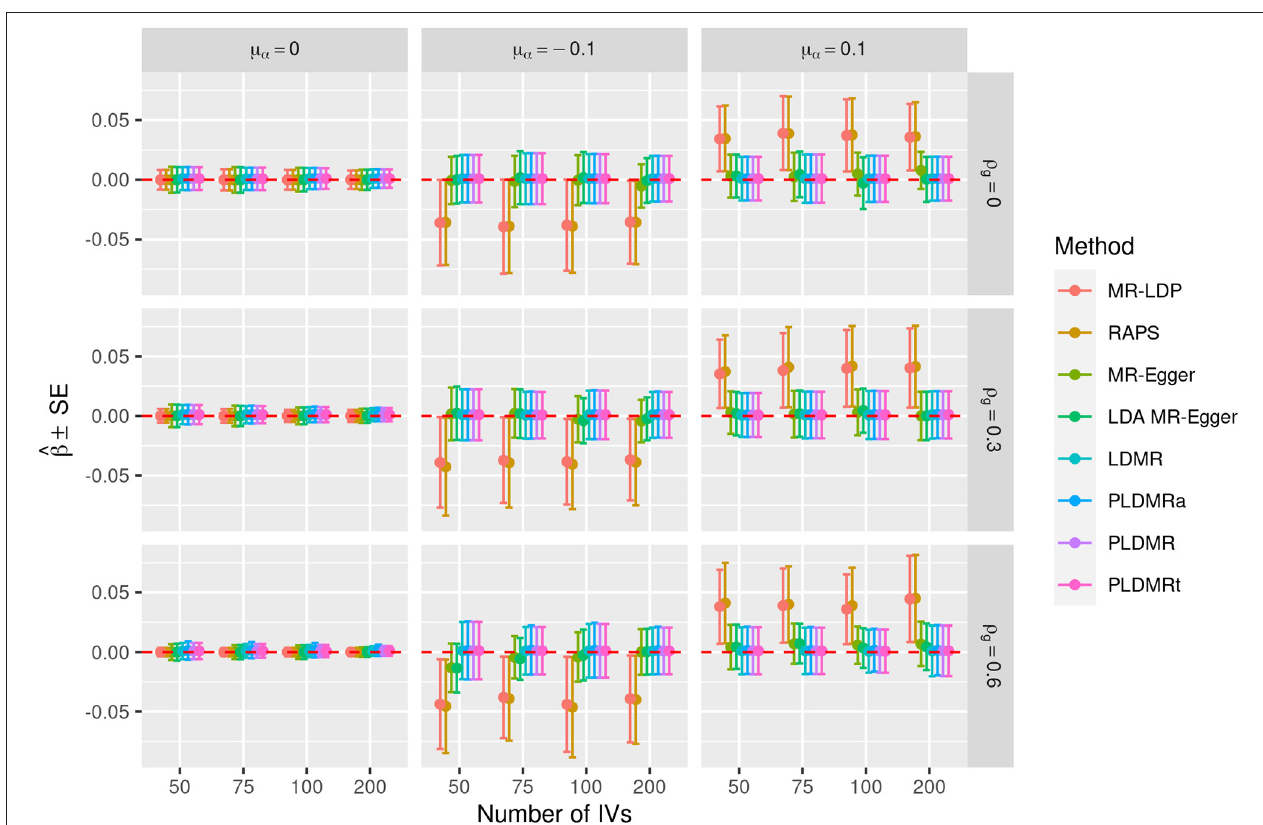
FIGURE 4 | Plot of the performances of all eight estimating methods when β = 0. Sample size is n = 5,000, σ α = 0.01, and the number of genetic variants m = 50,75,100,200. µ α = 0, − 0.1,0.1 represents the mean of pleiotropic effect and ρ g = 0,0.3,0.6 stands for the relative strength of LD between the genetic variants. The solid circles are the mean values of estimators, the upper and lower bars are the means plus and minus one standard error in 10,000 replications. The red dashed line indicates the true value of β .